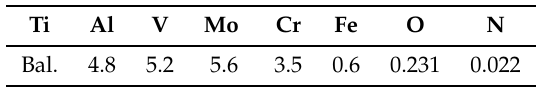
Table 1. Chemical composition of the Ti-5553 alloy (wt